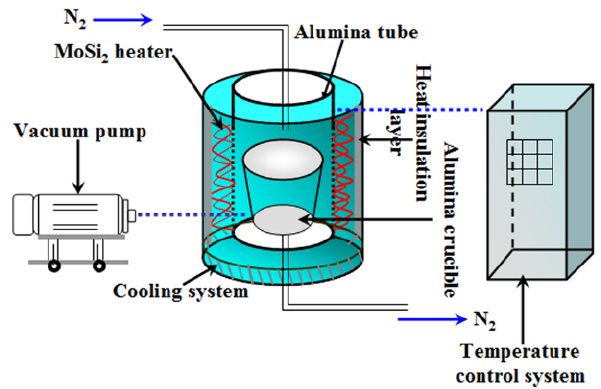
Figure 1. Nitridation apparatus for the preparation of α -Si 3 N 4 powder.